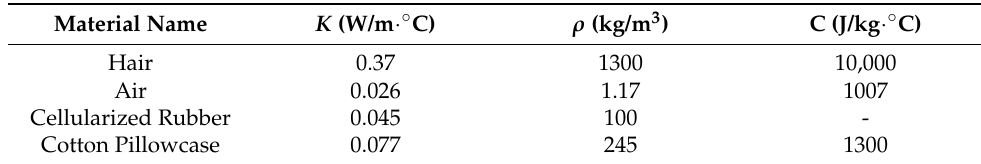
Table 2. Properties of materials related in the pillow